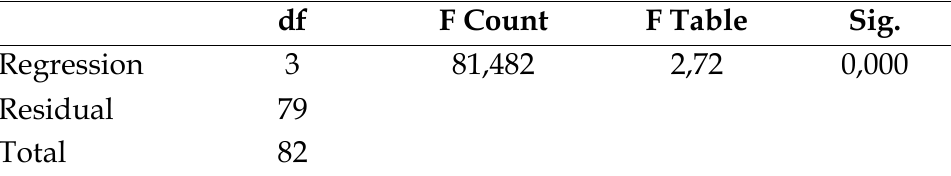
Anova Test Results